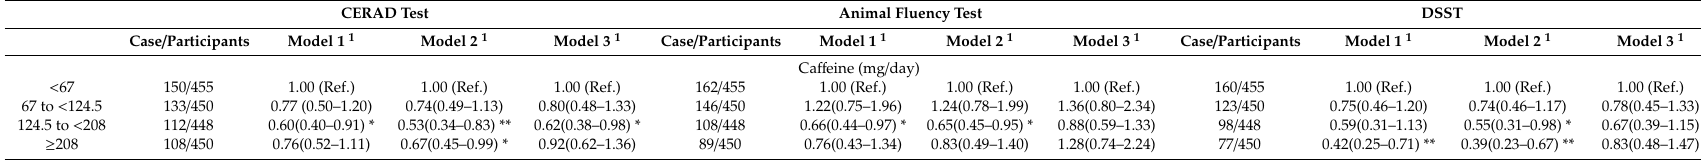
Table 4. Weighted odds ratios (95% confidence intervals) for scores on the Consortium to Establish a Registry for Alzheimer’s Disease (CERAD) test, Animal Fluency test and Digit Symbol Substitution Test (DSST) across quartiles of ca ff eine intake from co ff ee, NHANES 2011–2014 (N =